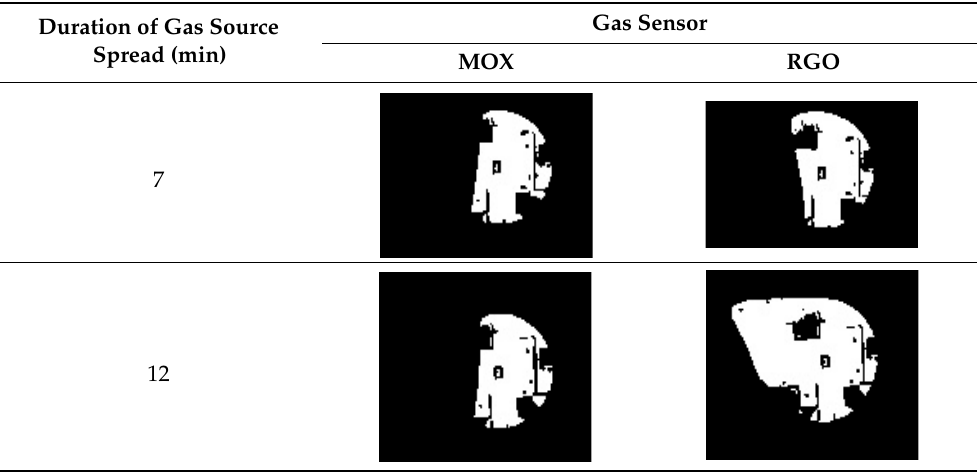
Table 4. Binary image of mean gas distribution.